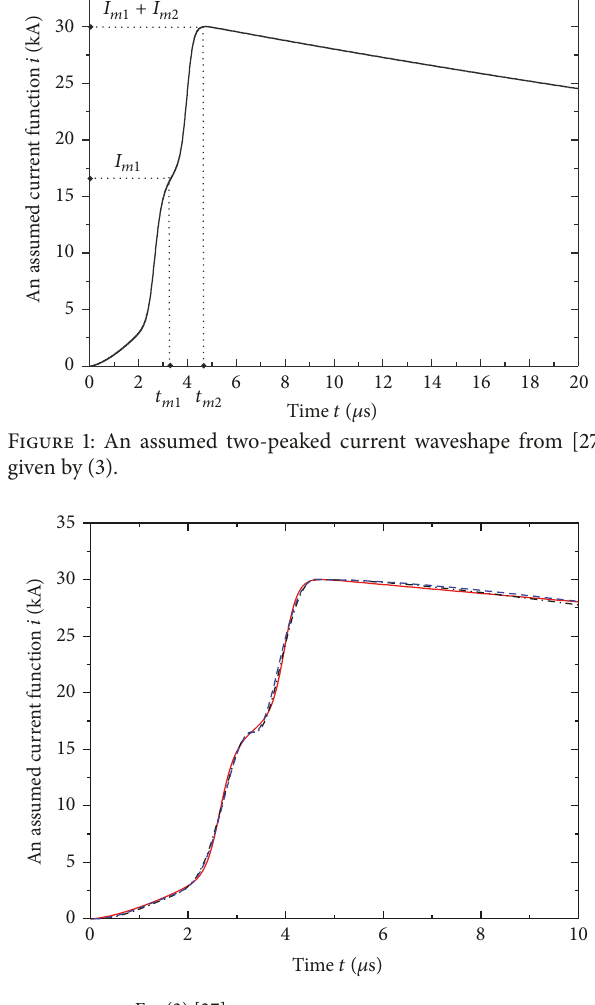
Table 1: Parameter settings for the genetic algorithm.